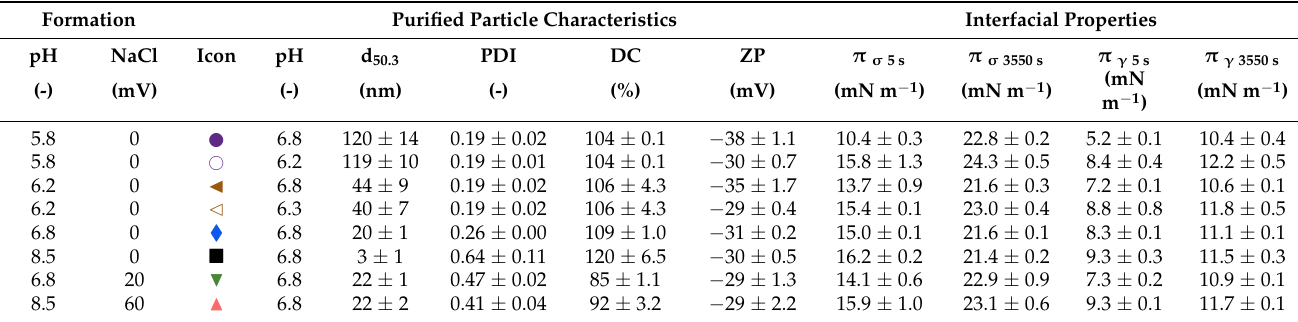
Table 2. Characteristics (median particle size (d 50.3 ), polydispersity index (PDI), degree of cross-linking (DC), and zeta potential (ZP)) and interfacial properties (surface ( π σ ) and interfacial pressure ( π γ ) after 5 and 3550 s) of purified ( DD